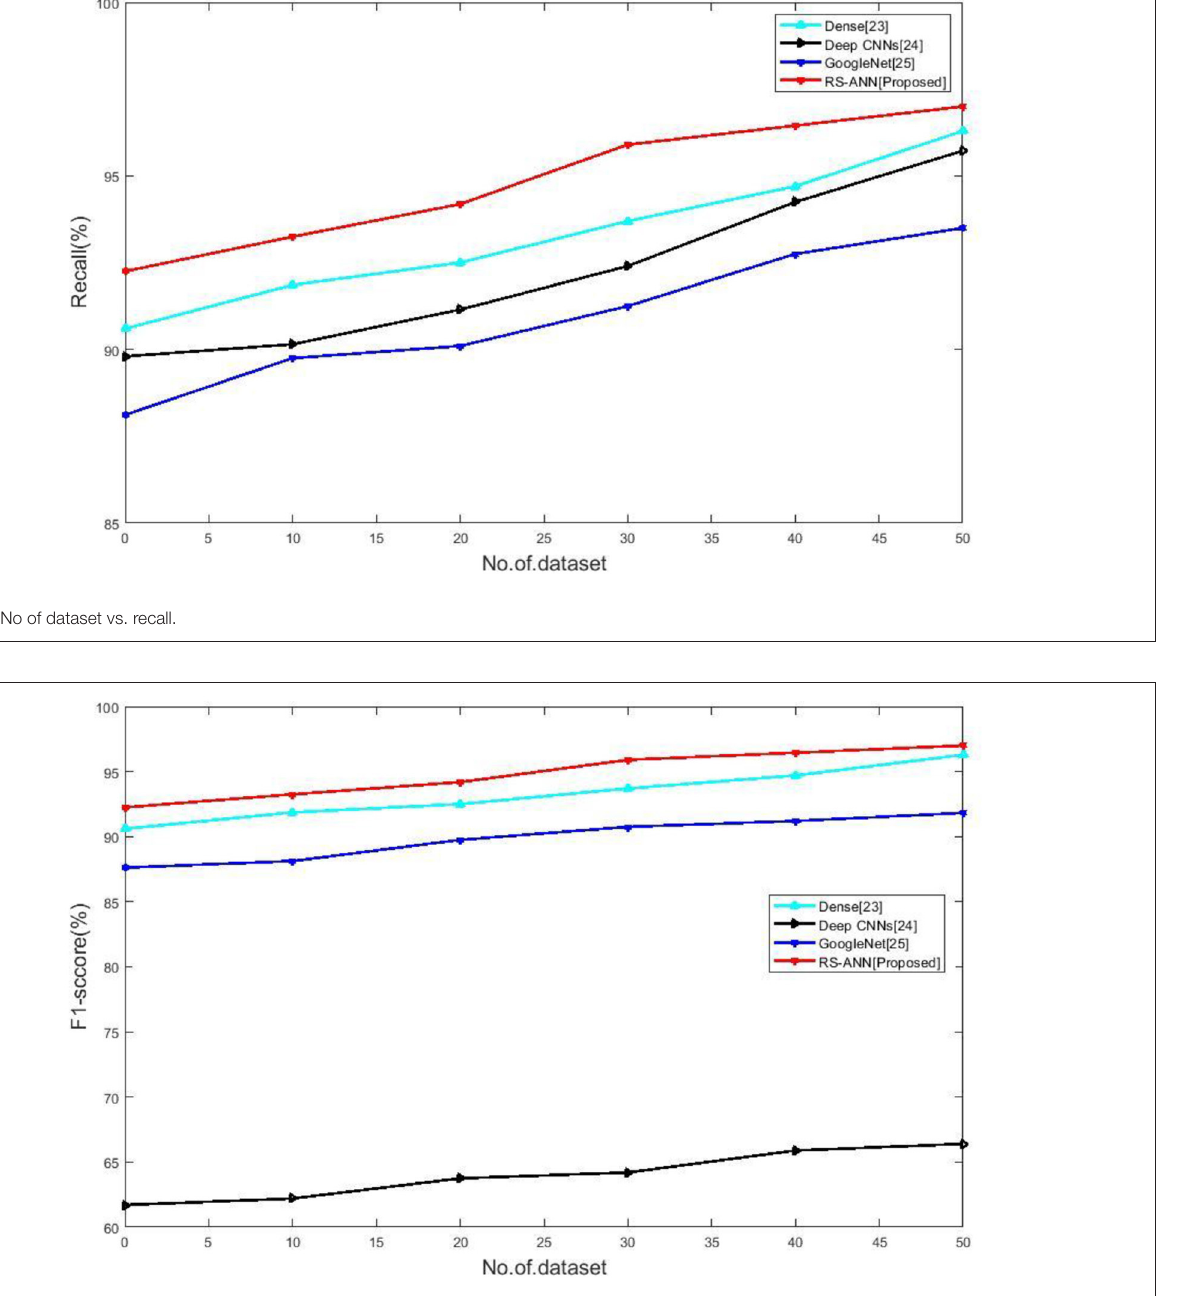
FIGURE 6 | No of dataset vs. F1-score.